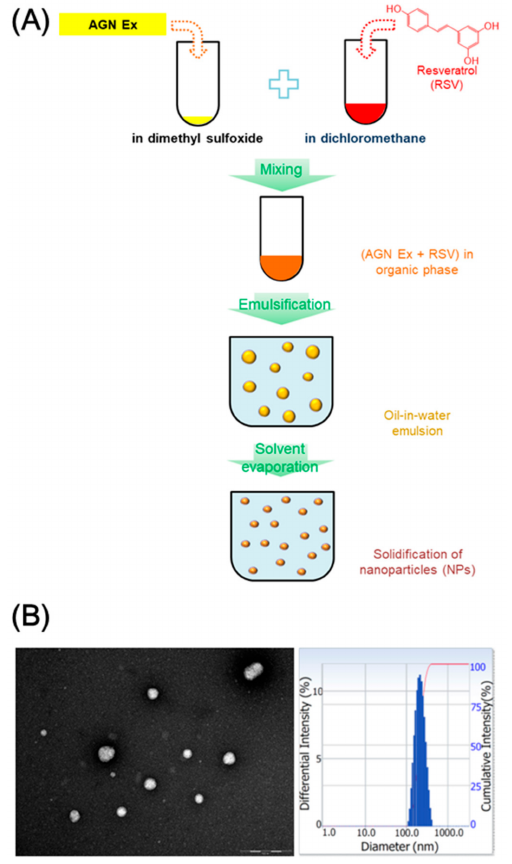
Figure 1. The fabrication and particle characterization of ethanol extract of Angelica gigas Nakai and resveratrol (AGN/RSV) nanoparticles (NPs). ( A ) The preparation method of AGN/RSV NPs; ( B ) The image of TEM (scale bar: 500 nm) and particle size distribution histogram of AGN/RSV